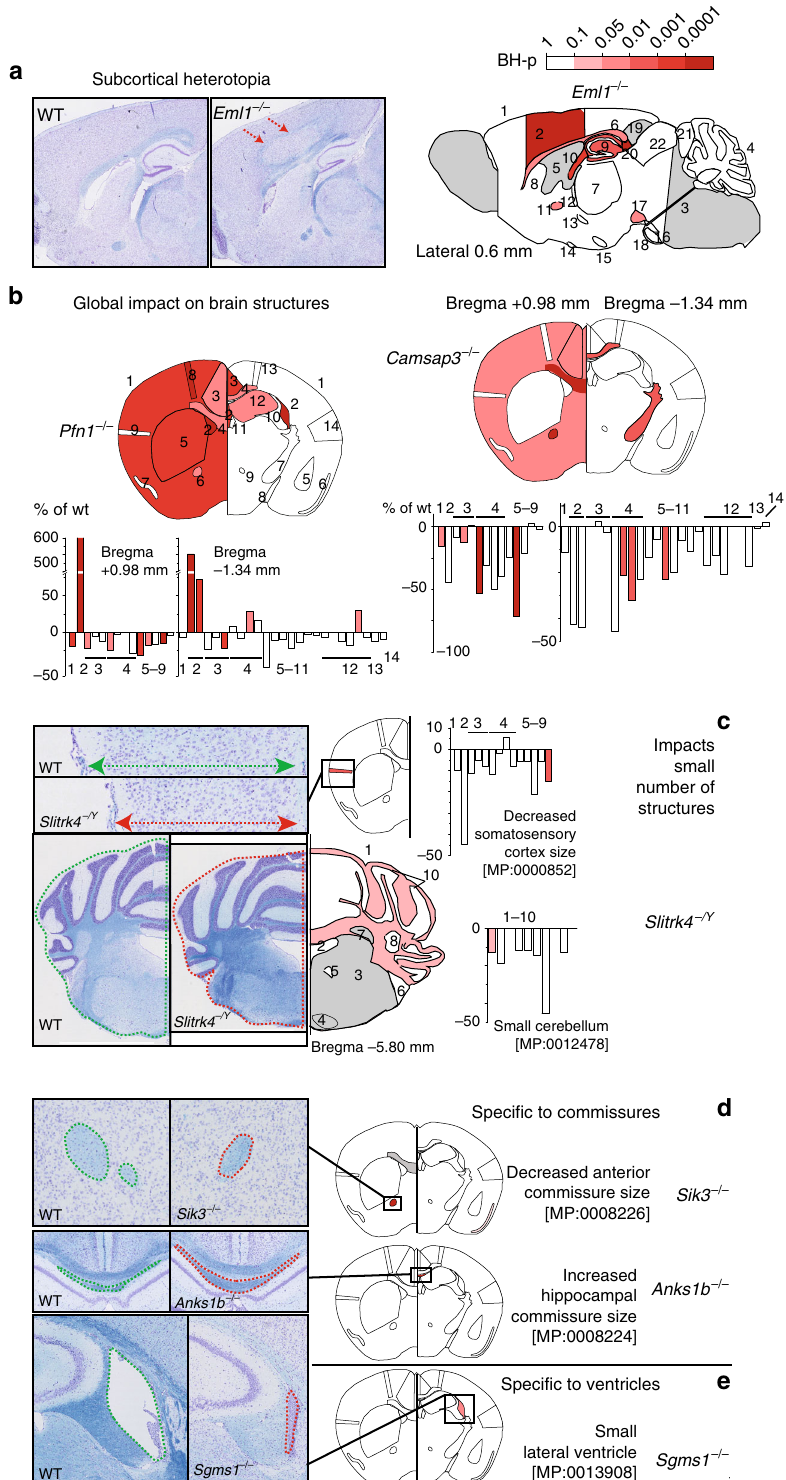
Fig. 2 Impact of mutations on the brain architecture. a Example of cortical heterotopia in Eml1 − / − (left) (image width 0.6 cm) and other affected brain regions mapped on a schematic representation of the sagittal plane at Lateral 0.6 mm. b Mutations having a global impact on the brain architecture ( Pfn1 + / − and Camsap3 − / − ) with brain parameters mapped on a schematic representation of the two coronal sections at Bregma + 0.98 mm and Bregma − 1.34 mm. Bar graphs detail which regions are affected using a color code corresponding to the adjusted Benjamini – Hochberg p value (BH-p). c Example of a mutation affecting a small number of parameters: the somatosensory cortex at Bregma + 0.98 mm (red arrow 0.09 cm) and the cerebellum at Bregma − 5.80 mm ( Slitrk4 − /Y ) (image width 0.3 cm). d , e Examples of mutations having a speci fi c impact on: d the commissures ( Sik3 − / − and Ank1b − / − ) (image width 0.06 cm for Sik3 − / − and Ank1b − / − ) and e the ventricles ( Sgms1 − / − ) (image width 0.1 cm for Sgms1 − / − ). Details of measurements appear in Supplementary Fig. 2. MP refers to the Mammalian Phenotype terms used to annotate the brain abnormalities (Supplementary Data